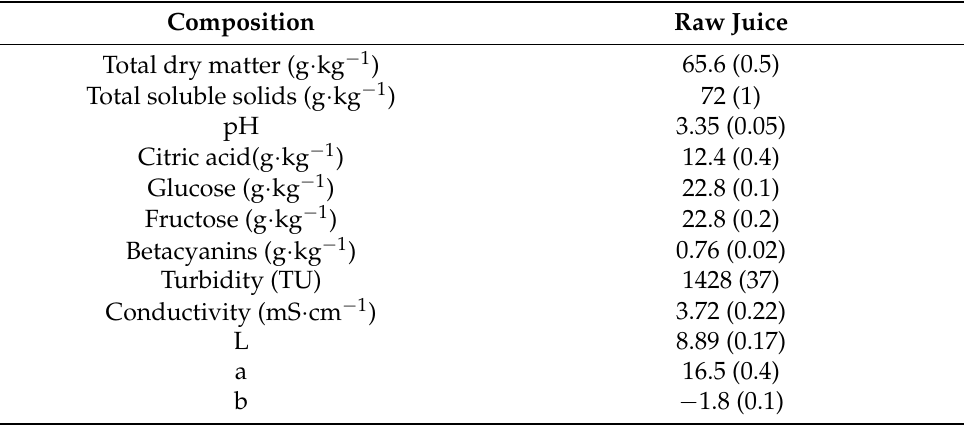
Table 1. Main characteristics of raw cactus pear juice from Tamba et al.